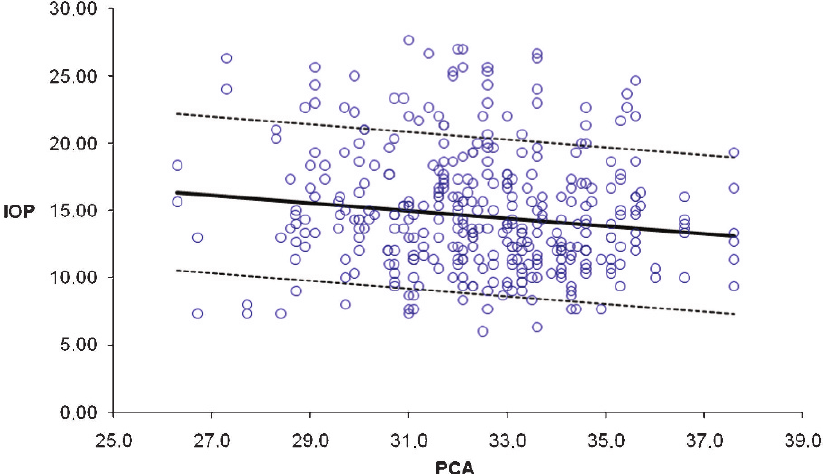
Figure 1 - IOP values for both eyes and their association with PCA. The lines indicate the mean values (center), 10th percentile (lower) and 90th percentile